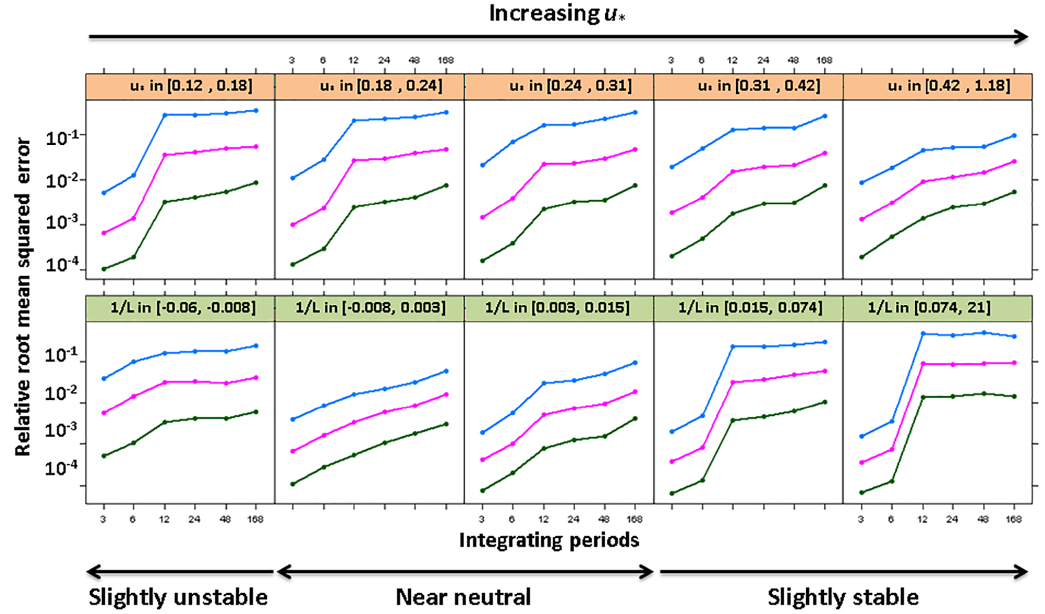
Figure 7. Relative root-mean-squared error as a function of integration period for stability factor and friction velocity classes for a single 25m side field. Medians and quartiles are given for equally sized bins of u ∗ and 1 /L and for the lowest sensor height (0.25m). The blue, pink and green curves are the third, second and first quartiles,